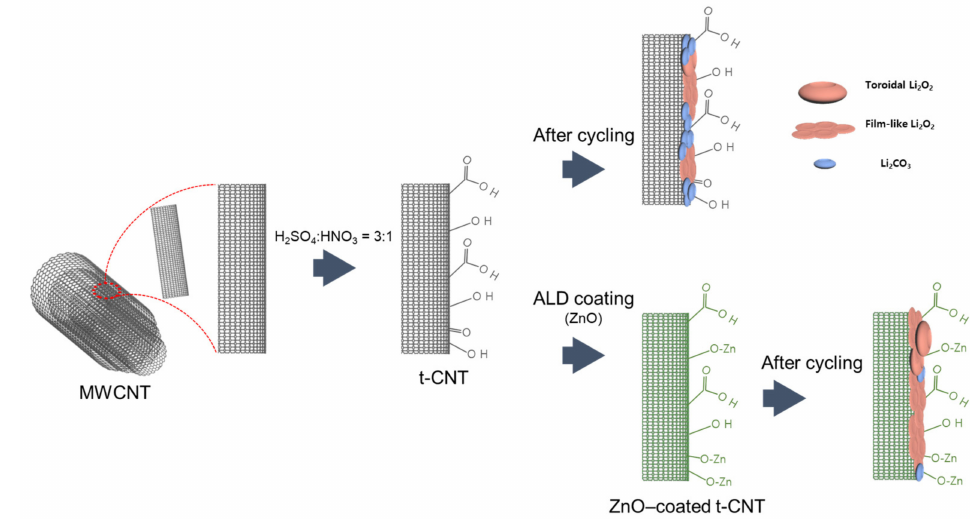
Figure 1. Scheme for the CNT functional groups modulation